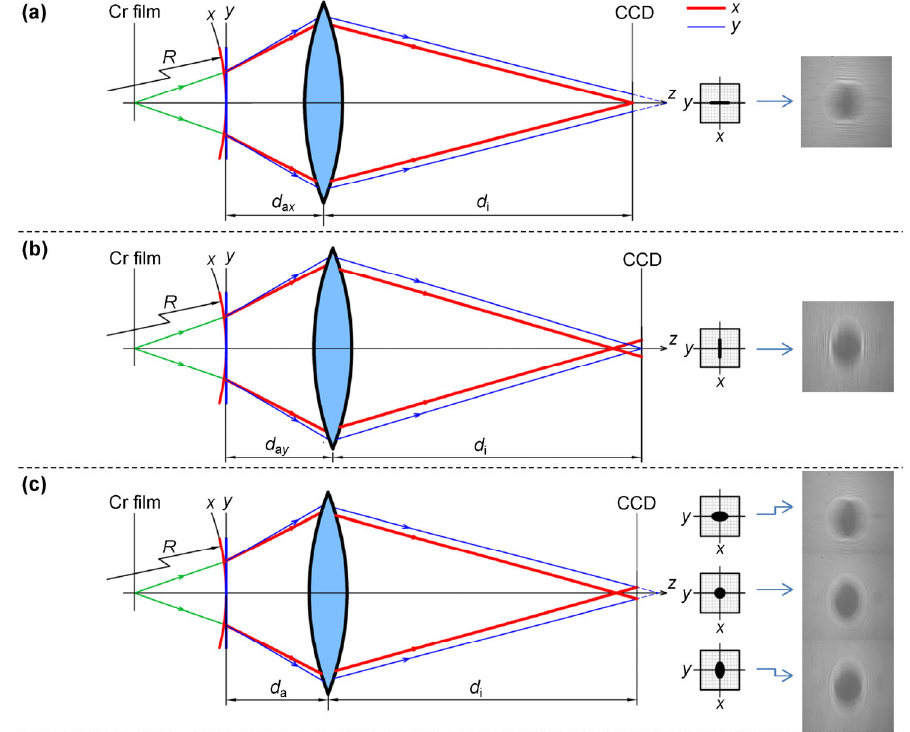
Fig. 5 Optical path diagram of an optical system showing different images of a point against d a.